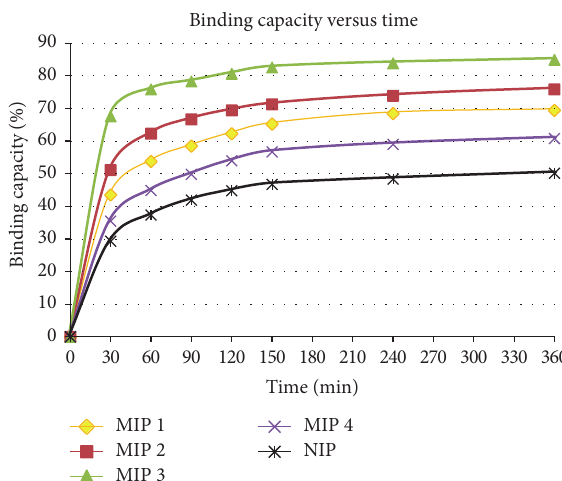
Figure 3: A graph of binding capacity of MIPs 1, 2, 3, and 4 and NIP at different time intervals.